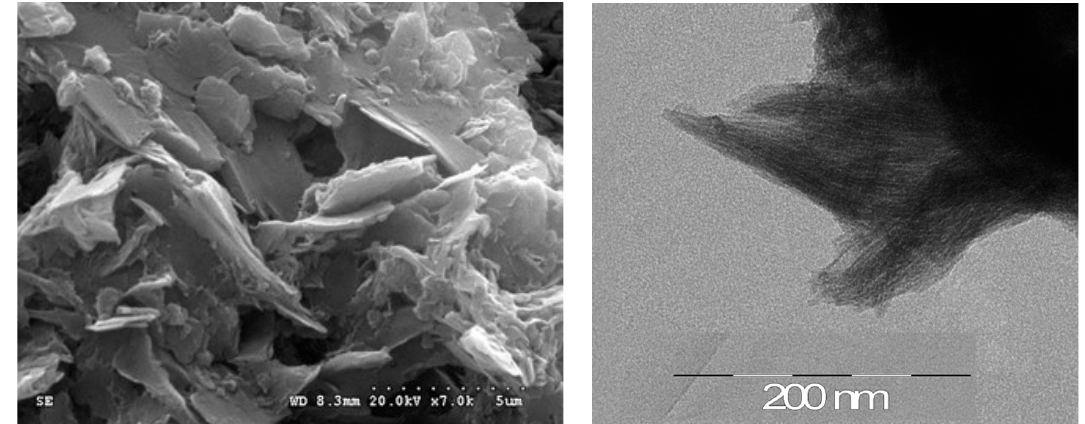
Figure 3. SEM ( left ) and TEM ( right ) images of the lamellar structure of M4 110 .